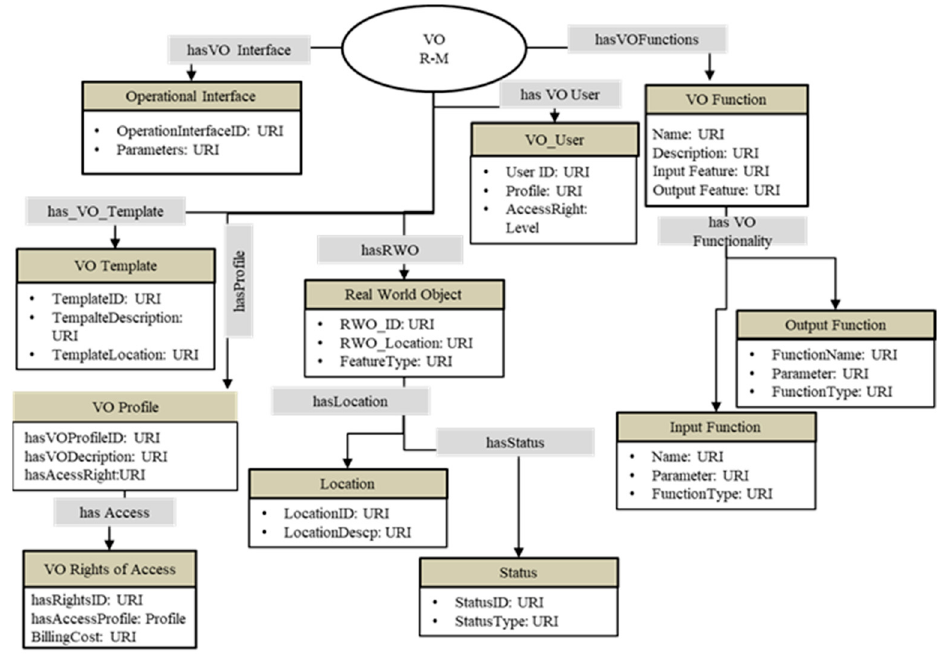
Figure 3. Representation model (R-M) of the Virtual Object (VO) to express Real World Object (RWO) and other information.